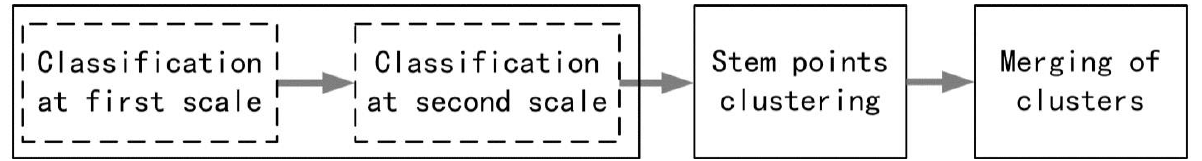
Figure 2. Phases of stem detection